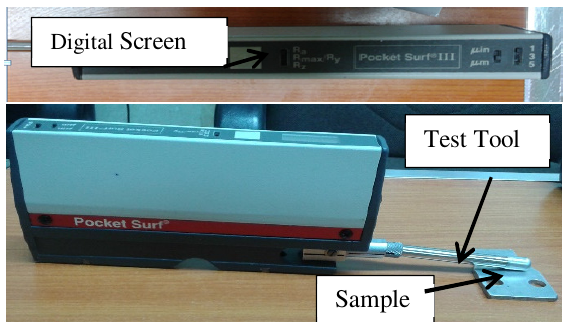
Fig. 7. Pocket surf IV Surface Roughness Testing Machine .